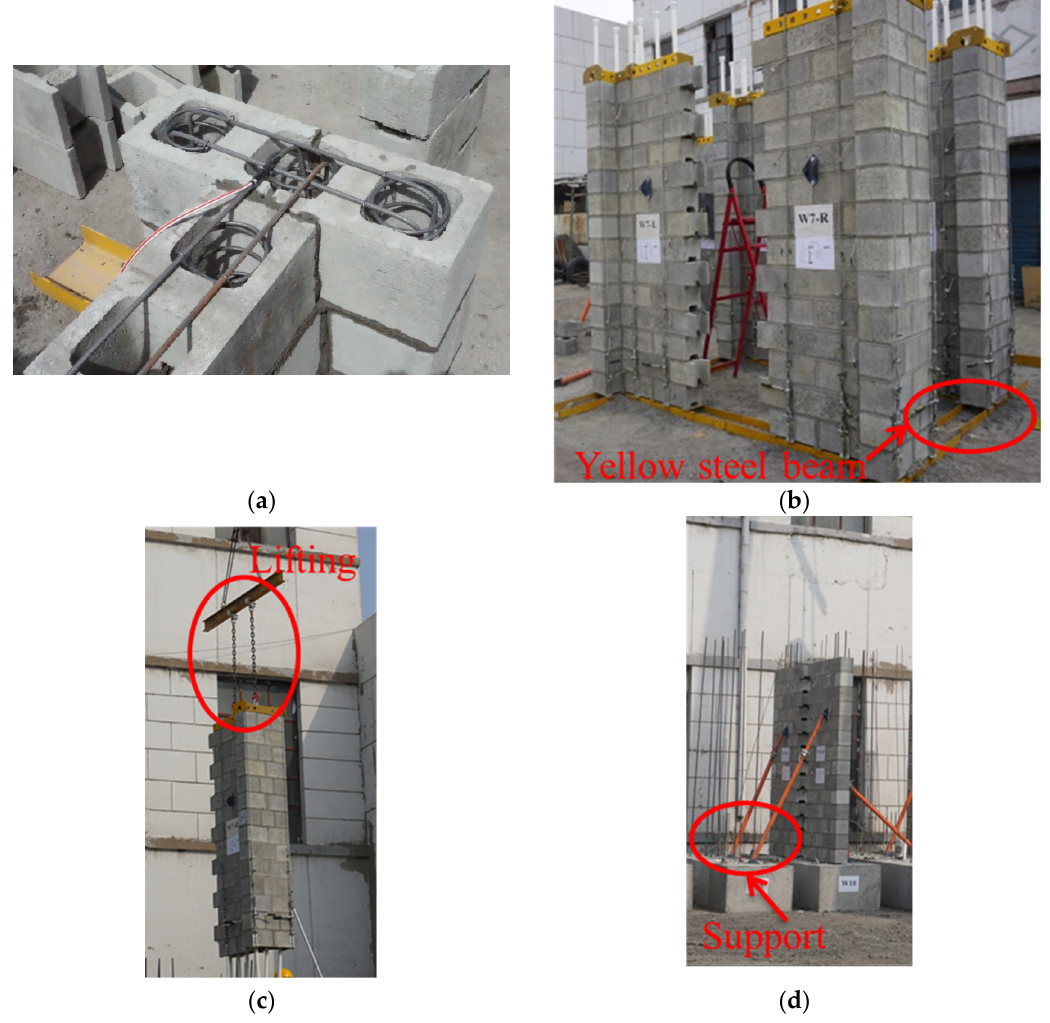
Figure 2. Construction details of test specimens with the prefabricated technique: ( a ) reinforcement configuration of hollow wall; ( b ) completion of hollow wall construction; ( c ) lifting of hollow wall; ( d ) adjustment and support of the